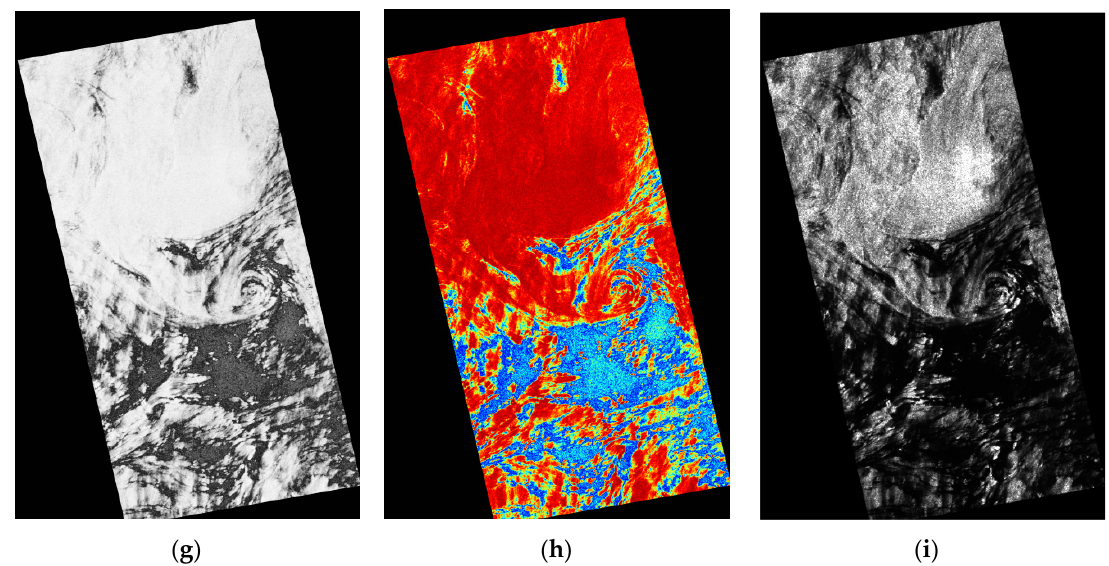
Figure 9. The CP feature images with improved performances for W-E detection under data #A: ( a ) 1mHA , ( b ) H , ( c ) SE P , ( d ) SE I , ( e ) SE , ( f ) p2 , ( g ) m , ( h ) A , and ( i ) σ VV .